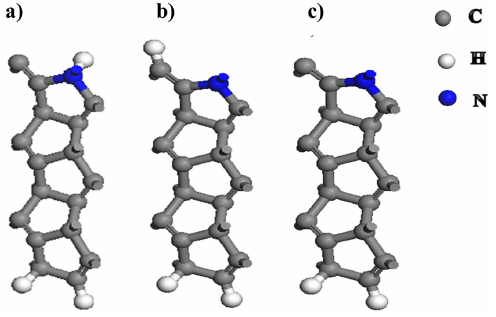
Figure 1: Schematic of possible N:SSPGNR adsor- bent sites for gas molecules, consisting of a) C-H- N:SSPGNR, b) H-N-N:SSPGNR, c) C-N-N:SSPGNR.